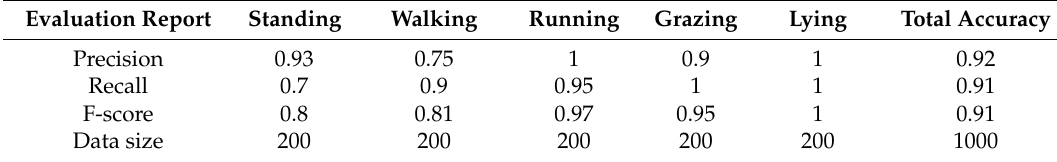
Table 7. Accuracy of the SVM